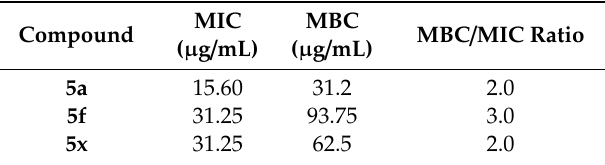
Table 2. MBC and MBC / MIC data of compounds 5a, 5f and 5x against E. Table 2 . MBC and MBC/MIC data of compounds 5a, 5f and 5x against E. coli.